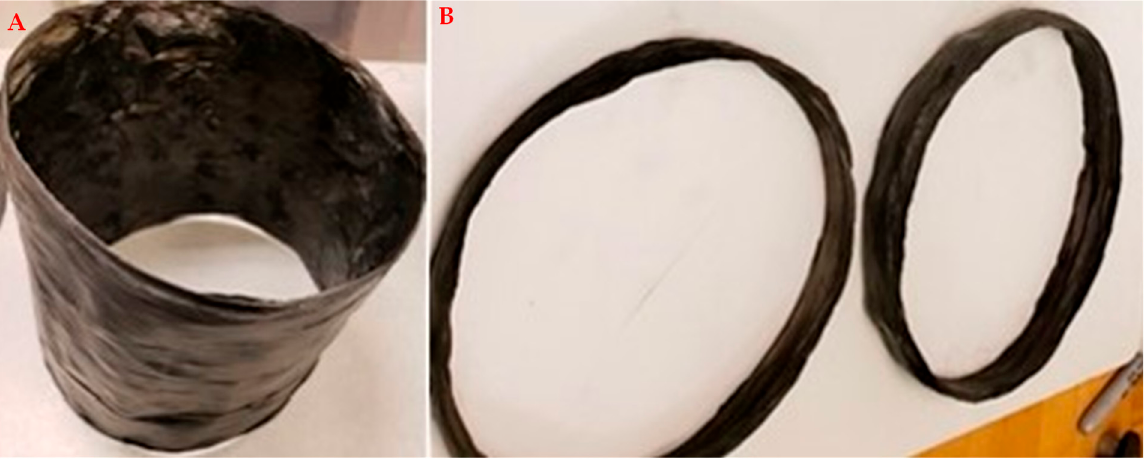
Figure 12. CF-CNT cylinders ( A , B ) rings. The material is flexible (not as brittle as CFRP) and is expected to have good tensile strength and toughness.